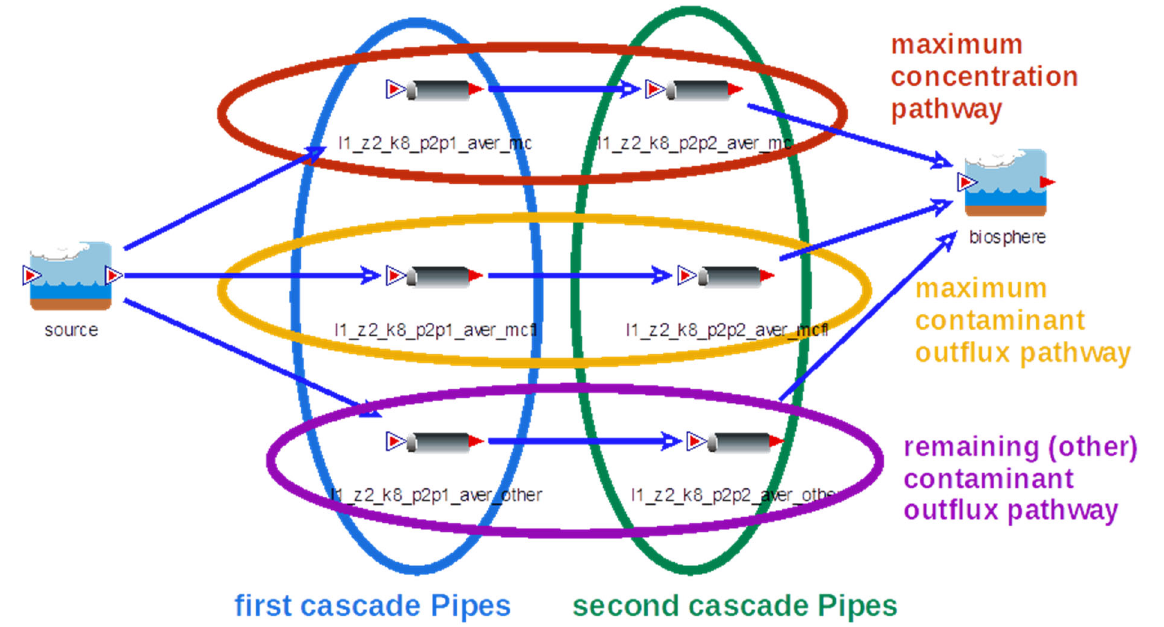
Figure 9. Arrangement of the GoldSim model of the three parallel paths, formed by pairs of cascade “Pipes”.